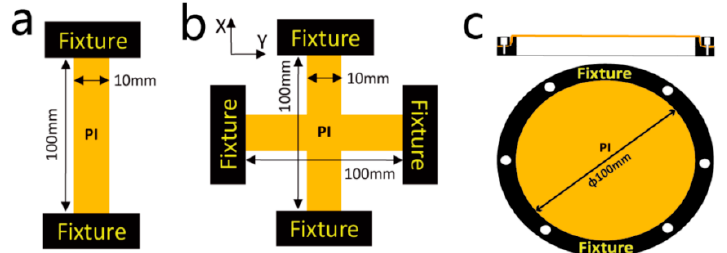
Figure 1. Schematic of polyimide (PI) membrane samples. Sample for uniaxial stretching test ( a ), sample for biaxial stretching test ( b ), and sample for circular stretching test ( c ).